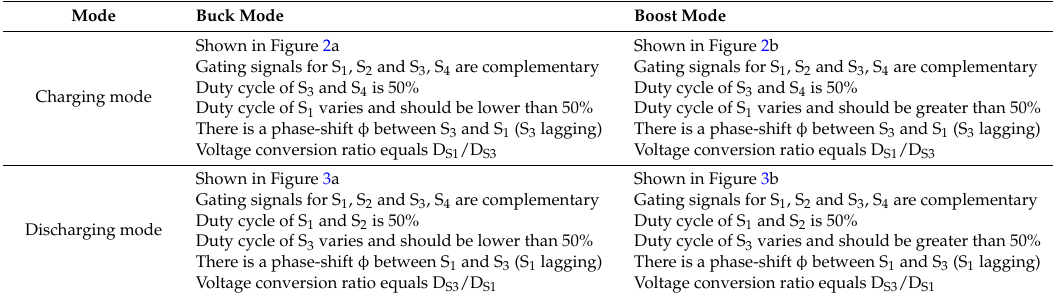
Table 1. The gating signals required for four operating modes.